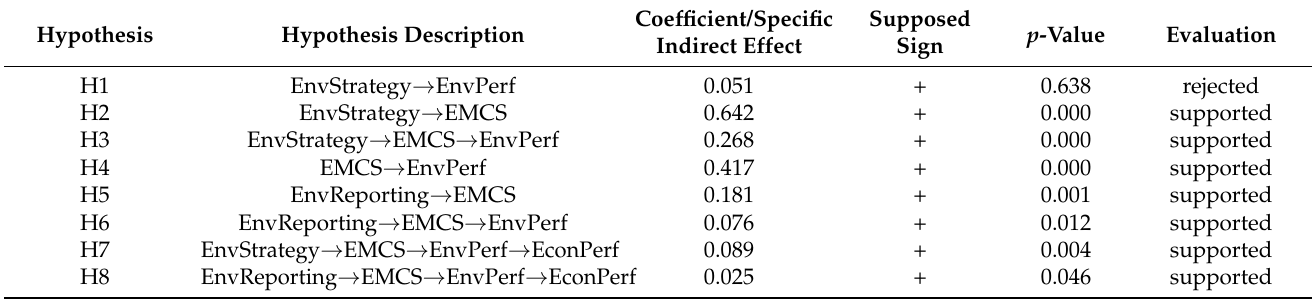
Table 6. Evaluation of